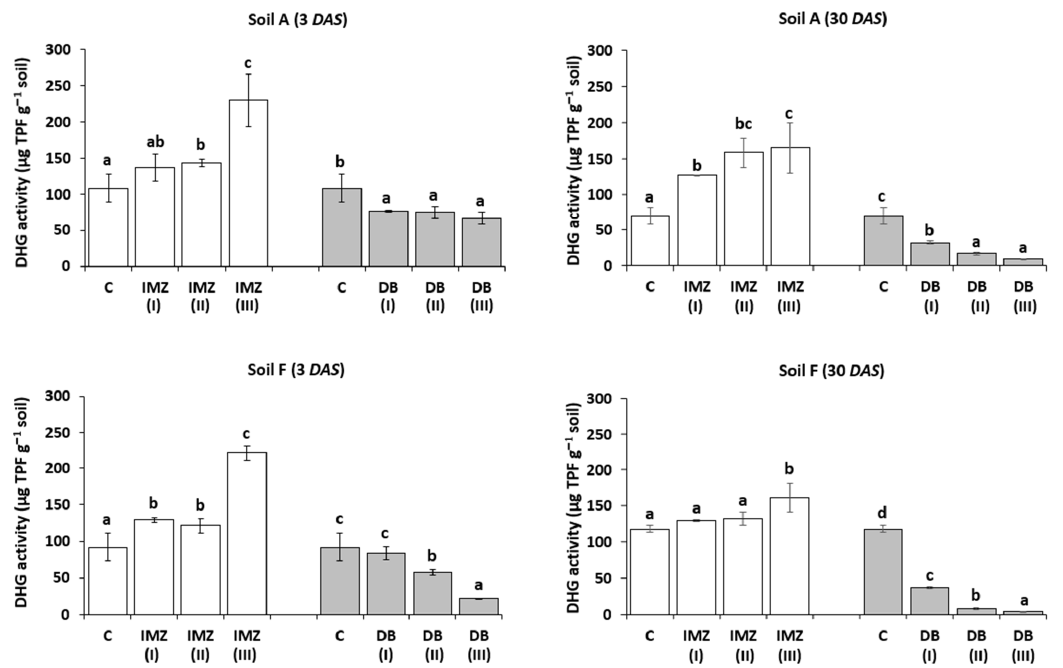
Figure 3. Influence of different concentrations of imazamox (IMZ) and 2,4-DB (DB) on soil dehydro- genase (DHG) activity (mean values ± SE) at 3 and 30 days after herbicide spiking ( DAS ). IMZ(I), (II) and (III) refer to 3, 15, 150 µg IMZ g − 1 soil, respectively. DB(I), (II) and (III) refer to 100, 500, 5000 µg DB g − 1 soil, respectively. C, control (untreated) soil. TPF, triphenylformazan. For each soil and herbicide, different letters on top of bars indicate statistically significant differences (Bonferroni cor- rected p -value < 0.05).